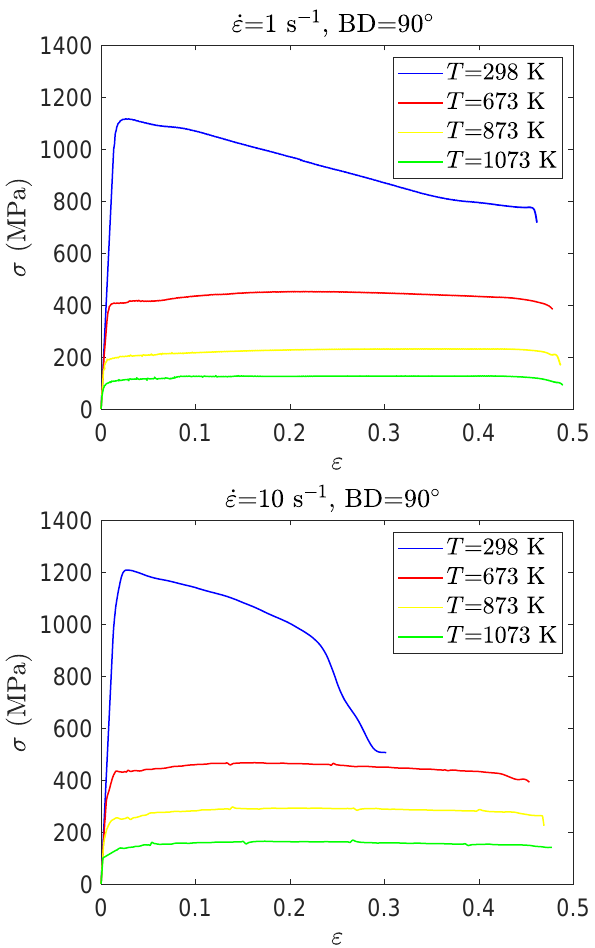
Figure 6. Stress–strain curves for the compression tests carried out on Ti42Nb specimens manufac- tured with a building direction of BD-90 ◦ deformed at different temperatures and strain